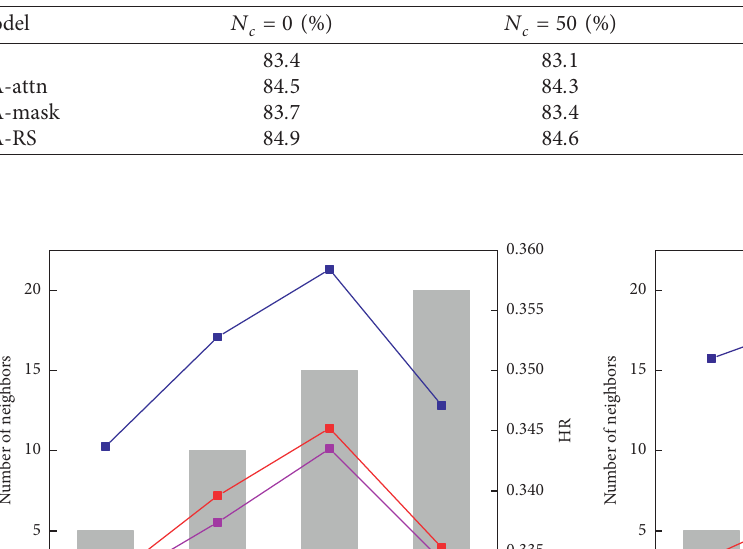
Table 5: Results of different cold-start users on Cora dataset.